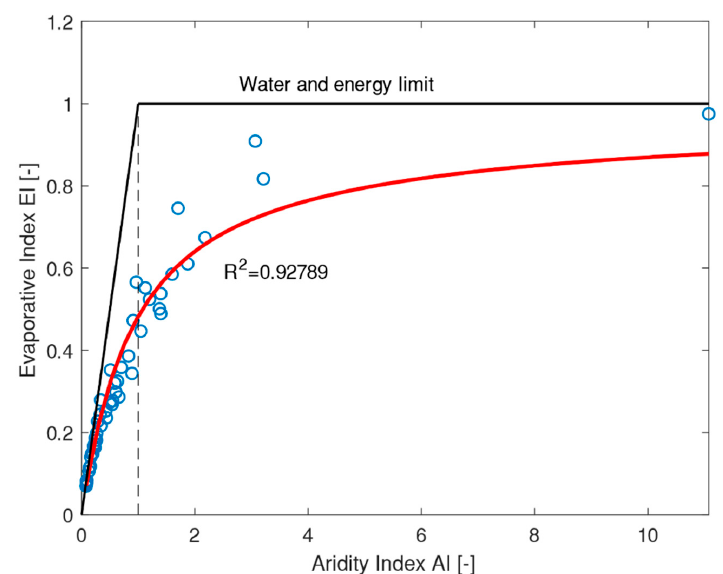
Figure 3. 𝐴𝐼 - 𝐸𝐼 ’s couples into the Budyko’s domain generated by the combination of weather Figure 3. AI - EI ’s couples into the Budyko’s domain generated by the combination of weather generator generator and conceptual model EHSM, the optimised Fu’s curve, and the related coefficient of and conceptual model EHSM, the optimised Fu’s curve, and the related coe ffi cient of determination determination value 𝑅 (cid:2870) for the climatic scenario 5 and the test-watershed (see Table 2) value R 2 for the climatic scenario 5 and the test-watershed (see Table 2).